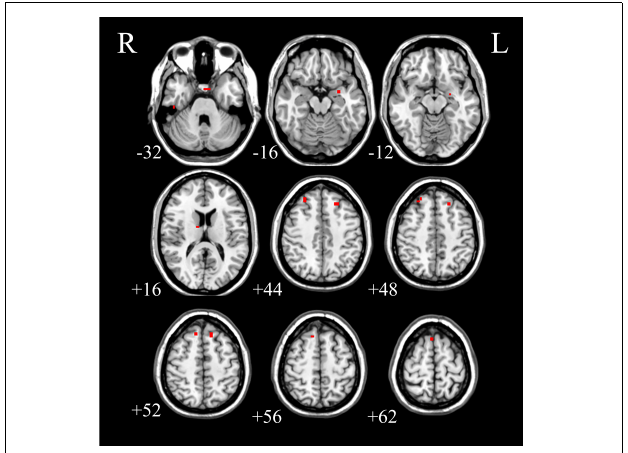
FIGURE 3 | The gray matter areas in abnormal functional covariance connections. Areas marked in red are brain gray matter areas where FCS is statistically different between the PDH and HC groups (two sample t -test, p < 0.05, FDR correction).